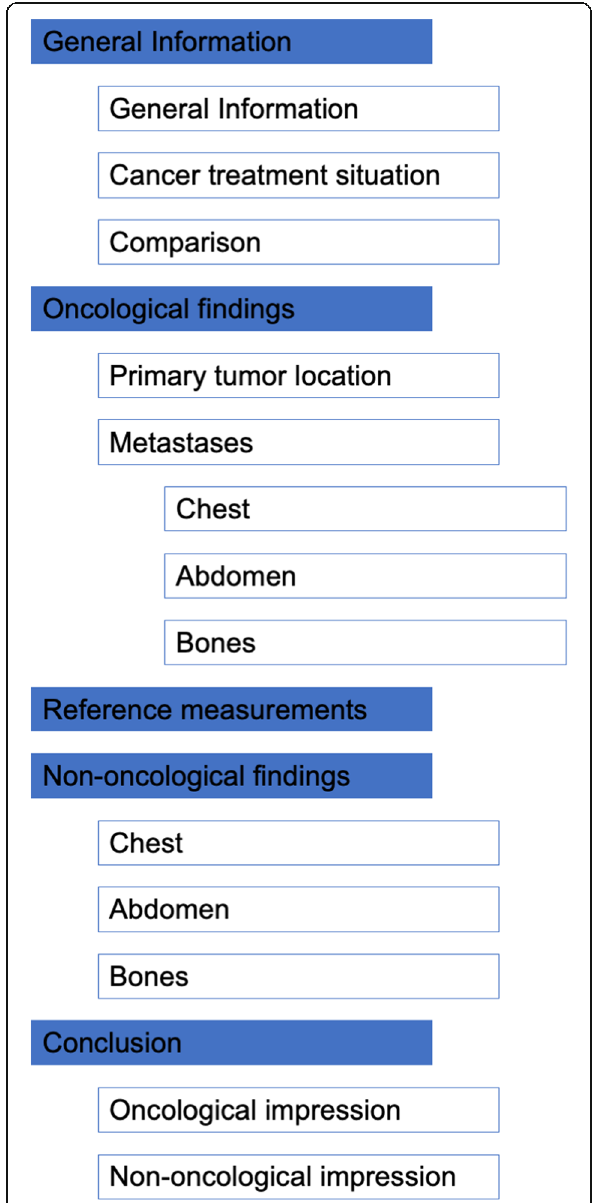
Fig. 1 Schematic illustration of layout of structured oncology